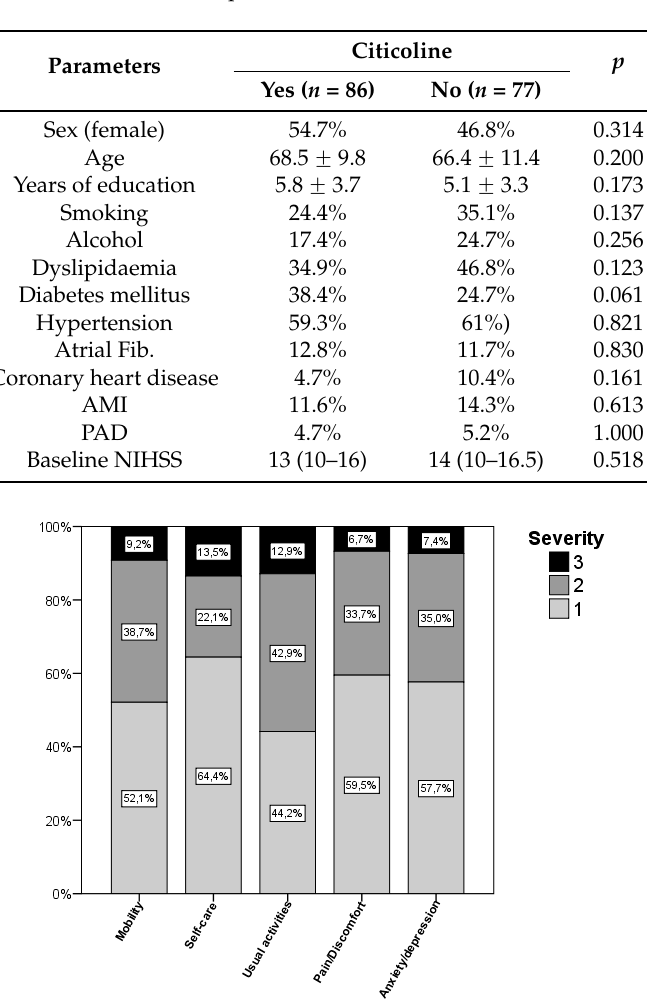
Table 1. Baseline characteristics in patients who received and did not received citicoline.